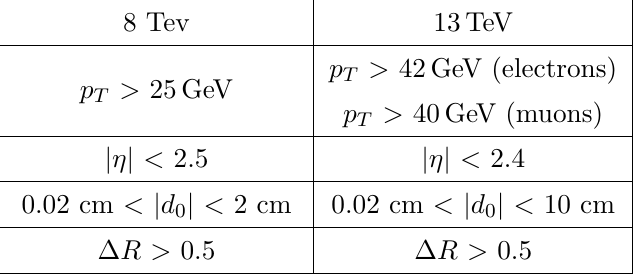
, pseudorapidity η and T